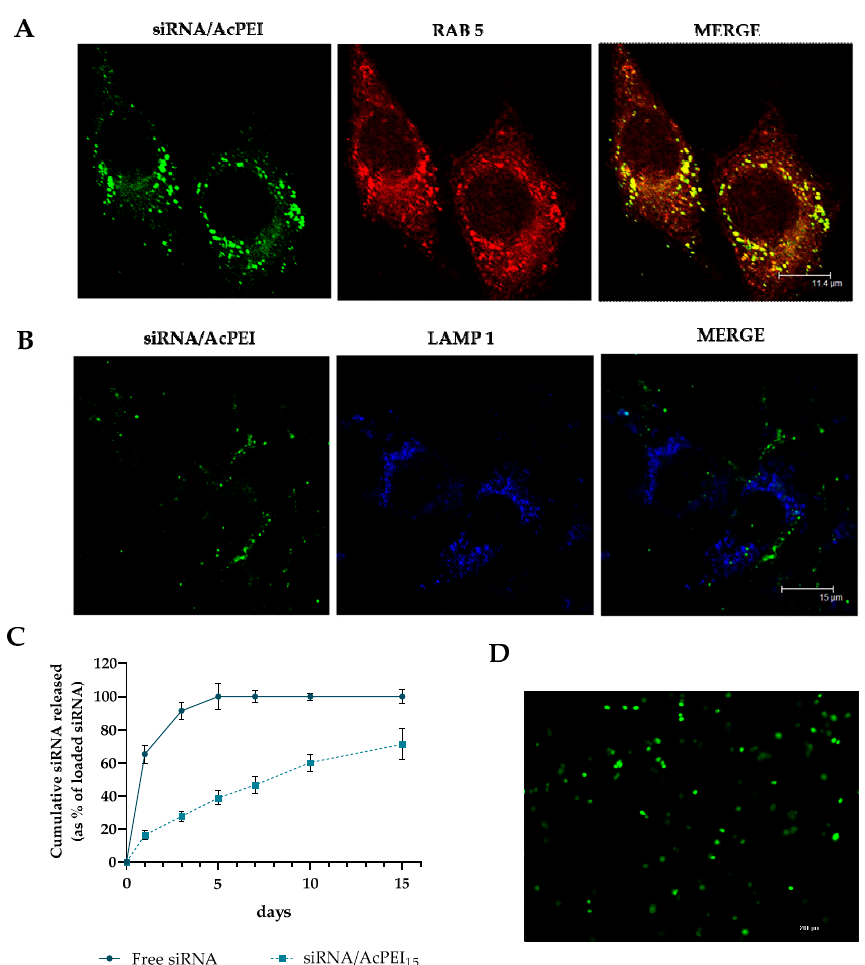
Figure 3. ( A ) Representative confocal microscopy images showing Cy5-siRNA colocalization with early endosomes tagged via a Rab5-Texas red fusion protein (scale bars, 15 µ m). Yellow dots indicate regions of siRNA colocalized with Rab5 early endosomes. ( B ) Representative confocal microscopy images showing Cy5-siRNA colocalization with lysosomes tagged via a LAMP1. Areas of colocalization appear yellow in the merged image (scale bars, 200 µ m). ( C ) Cumulative release profile of free siRNA and siRNA/AcPEI loaded in collagen matrix. The bars represent the means ± standard deviation (n = 3). ( D ) Confocal microscopy of PC3 cells cultured in 3D collagen matrix loaded with fluorescent nanocomplexes. Fluorescence micrograph at 20× magnification.